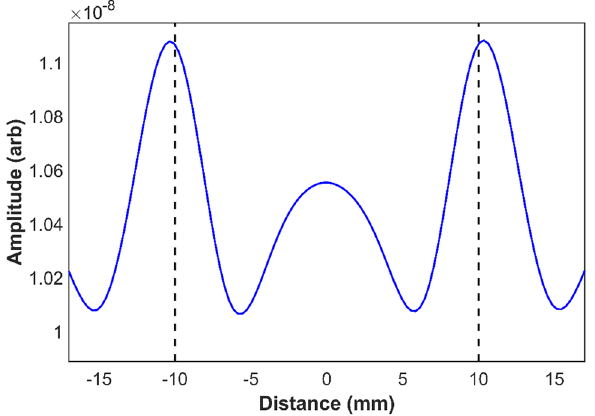
Figure 9. Numerical results from 10X magnifying flat face hyperlens showing the magnified image for defects separated by a subwavelength distance of 2 mm (λ/3). The dotted lines show the expected locations of the defects in the magnified